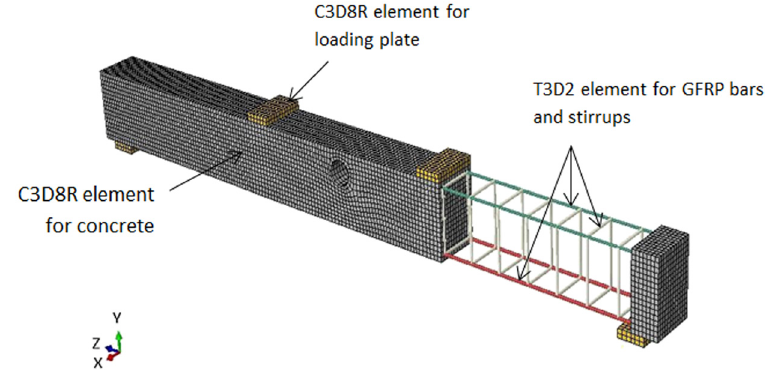
Figure 4: FE mesh and discretization of a typical model.